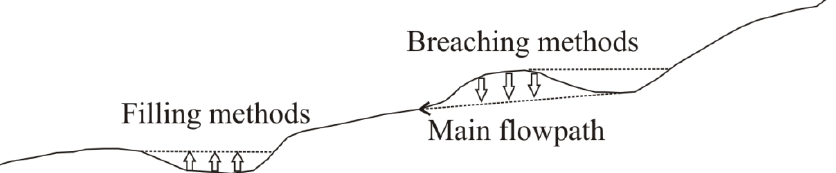
Figure 2. Main principles of depression preprocessing methods. Depressions are caused by underestimation of elevation values following filling methods that raise elevation values of depression pixels. With the breaching methods, however, depressions are caused by overestimation of elevation values which form topographic features that block water